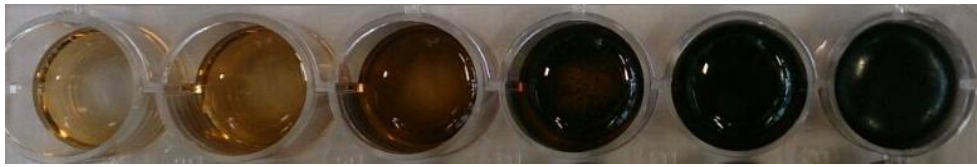
Figure 2. A photograph of s 24-well plate showing the change in colour of the alkaline dopamine solutions over 6 h, 12 h, 24 h, 48 h, 72 h, and 96 h, shown from left to right, respectively.